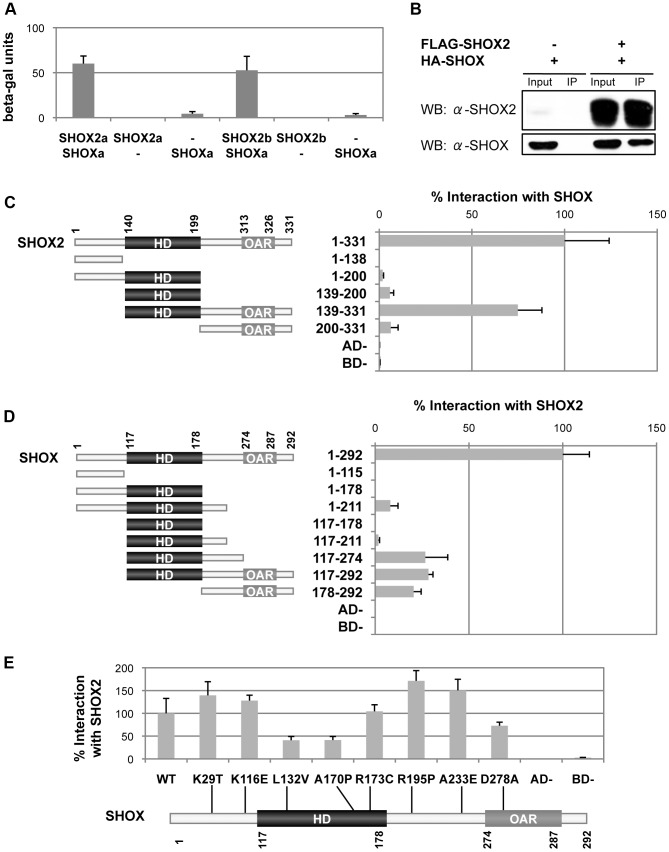
Identification and characterization of the SHOX2-SHOX interaction.A) SHOX2 interacts with SHOX in the yeast-two hybrid system. The S. cerevisiae strain Y187 was cotransformed with the pGBT9 (BD) and pACT2 (AD) vectors. Interactions were determined by using a β-galactosidase liquid assay with CRPG as substrate. Empty vectors were employed as negative controls. B) SHOX2 interacts with SHOX in human cells. Nuclear extracts of HEK293 cells overexpressing FLAG:SHOX2 and HA:SHOX were immunoprecipitated using anti-FLAG-agarose. Western blots (WB) of immunoprecipitates (IP) were probed with SHOX2 and SHOX antibodies. Nuclear extracts corresponding to 10% input were included as protein expression controls and nuclear extract immunoprecipitates of cells transfected only with HA:SHOX were included as negative controls. The western-blot images clearly show that SHOX immunoprecipitate only in the presence of SHOX2. C) Characterization of the SHOX2 domains involved in the interaction with SHOX. A scheme of the SHOX2 protein structure showing the amino acid location of the homeodomain (HD) and the OAR domain is drawn together with the various SHOX2 fragments analysed, indicating the name of each fragment the amino acids that they contain. Yeast two-hybrid assay of Y187 cells cotransformed with SHOX in the pGBT9 vector and different SHOX2 fragments in the pACT2 vector. Protein interaction percentages were obtained by normalizing the β-galactosidase units of the different SHOX2 fragments to that obtained with full-length SHOX2. Empty vectors were employed as negative controls. D) Characterization of the SHOX domains involved in the interaction with SHOX2 using the yeast two-hybrid assay. An scheme of the SHOX protein structure showing the amino acid location of the homeodomain (HD) and the OAR domain is shown with the various SHOX fragments analysed, indicating their name and the amino acids that they contain. To the right of each fragment are the corresponding yeast two-hybrid results. Y187 cells were cotransformed with the different SHOX fragments in the pGBT9 vector and with SHOX2 in the pACT2 vector. Protein interaction percentages were obtained by normalizing the β-galactosidase units of the different SHOX fragments to that obtained with full-length SHOX. Empty vectors were employed as negative controls. E) SHOX mutants impair the SHOX2-SHOX interaction. Schematic structure of SHOX showing the homeodomain (HD), the OAR domain and the localization of the eight analyzed missense mutations. Yeast two-hybrid assay of Y187 cotransformed cells with the different SHOX mutants in the pGBT9 vector and SHOX2 in the pACT2 vector. Protein interaction percentages were obtained by normalizing the β-galactosidase units of the various SHOX mutants to the wildtype SHOX. Empty vectors were employed as negative controls.